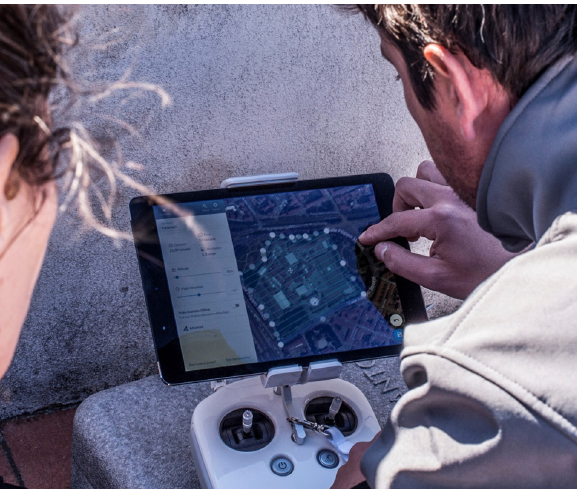
Figure 7. Set up of the UAV fly controller according to the planned